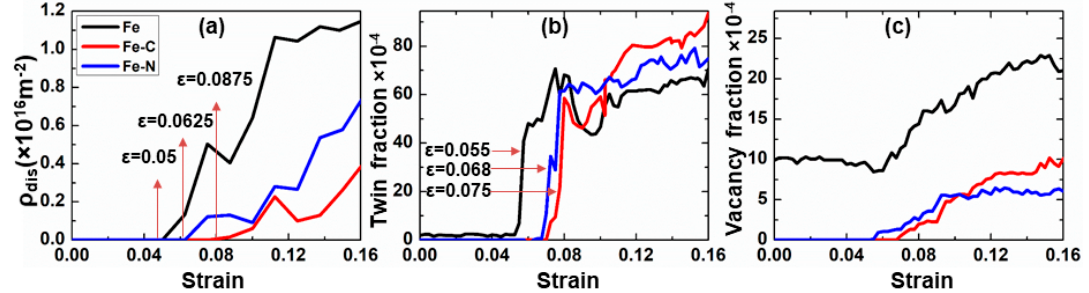
ρ , ( b ) twin fraction, and ( c ) vacancy